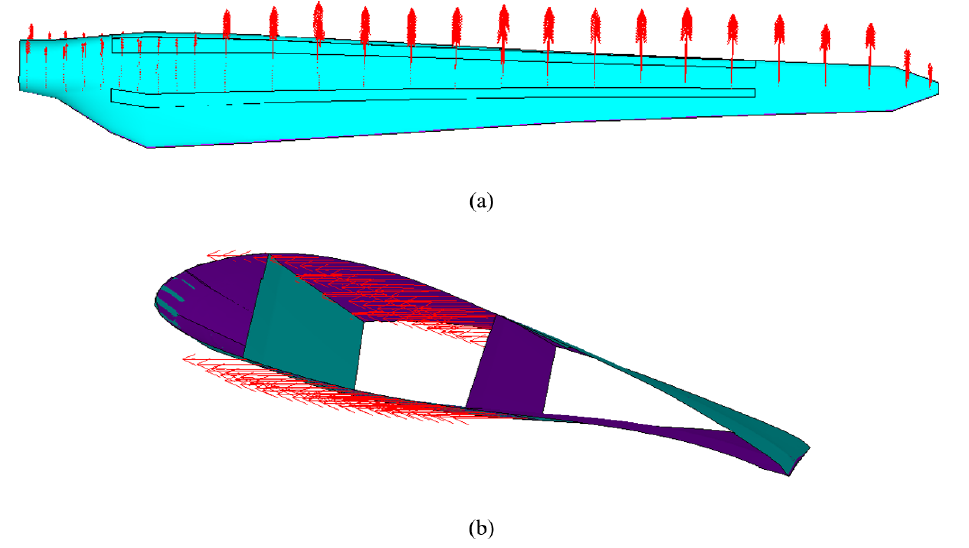
Figure 11. Extreme edgewise load application to blade FE model: (a) top and (b) cross-section view.